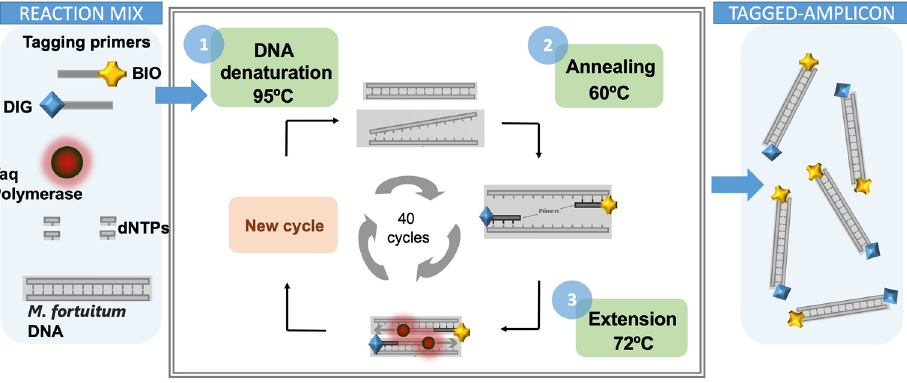
Figure 3. Schematic representation of the double-tagging PCR amplification, in order to obtain the double-tagged amplicon labeled with biotin (BIO) and digoxigenin (DIG) from M. fortuitum DNA.